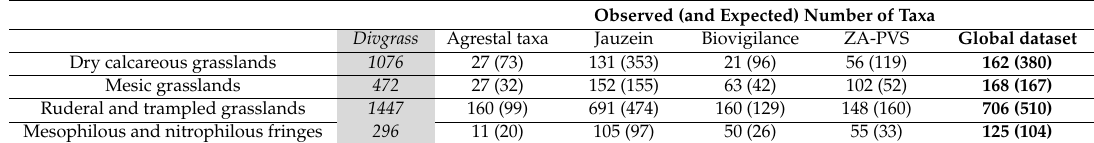
Figure 1. Venn diagram of species numbers in (i) Jauzein’s French flora, (ii) Biovigilance National plot-based survey in France, (iii) ZA-PVS regional plot-based survey in Western France. Table 2. Habitat types to which most weed taxa (white columns) and non-weed taxa (grey column, Divgrass database) belong. The habitats were derived from an analysis of species co-occurrences in the Divgrass database of open vegetation in France. The expected numbers of taxa for each list of weed taxa were calculated based on the proportions of taxa across habitats in Divgrass dataset (grey column, italic). When comparing species counts in Divgrass to the counts in each list, the di ff erence of proportions across habitats is always significant ( χ 2 tests, all p <